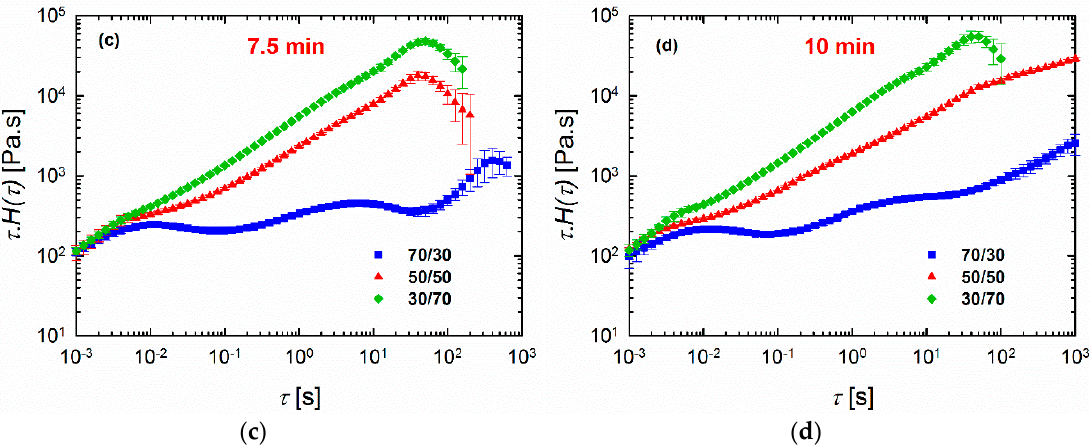
Figure 6. Weighted relaxation spectra of ( a ) neat polymers and ( b – d ) 70/30, 50/50, and 30/70 PLA/PVDF blends processed for ( b ) 5 min, ( c ) 7.5 min, and ( d ) 10 min at 200 °C.